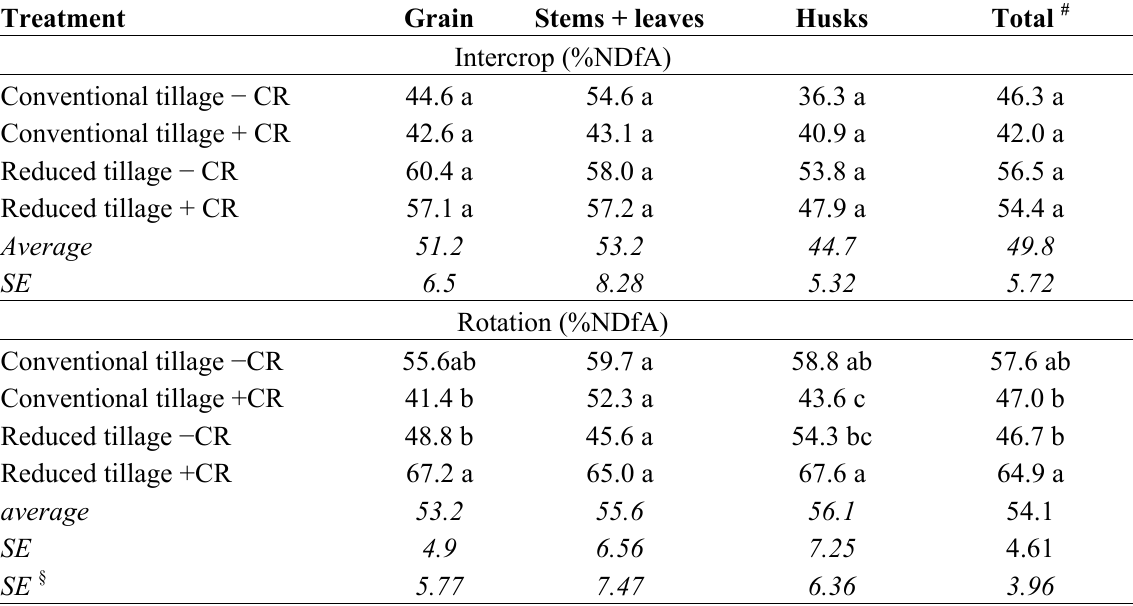
Table 4. Nitrogen derived from the air (%NDfA) from soybean intercropped and rotated with maize in Nyabeda, western Kenya, March–August 2007 cropping